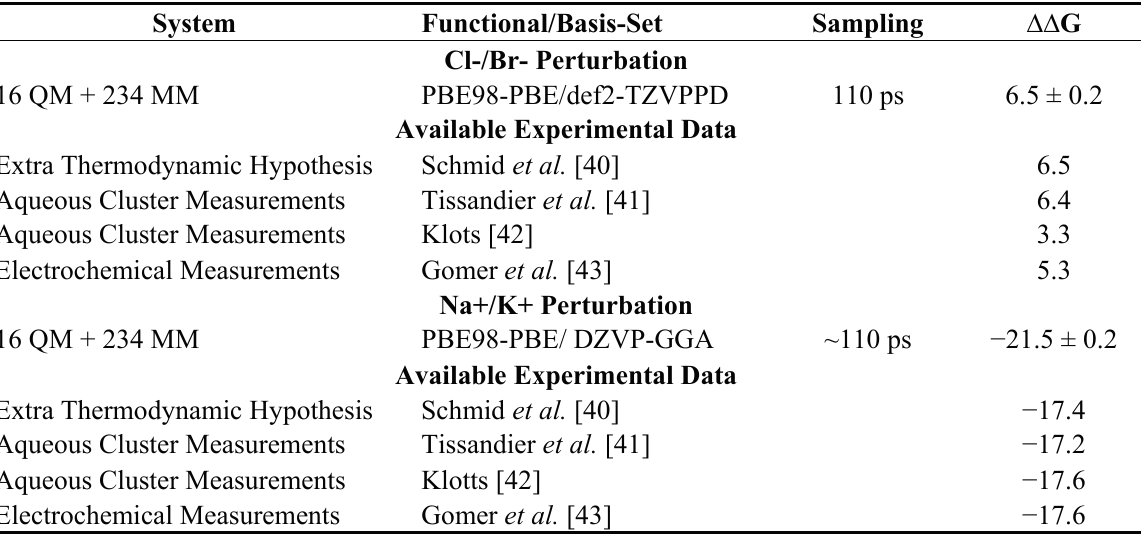
Table 1. FEP results for monovalent ion pair perturbation in comparison to experimental data. The free energy difference is presented in kcal/mol. Standard deviations for WHAM (Weighted Histogram Analysis Method) calculations were estimated using block averaging over three